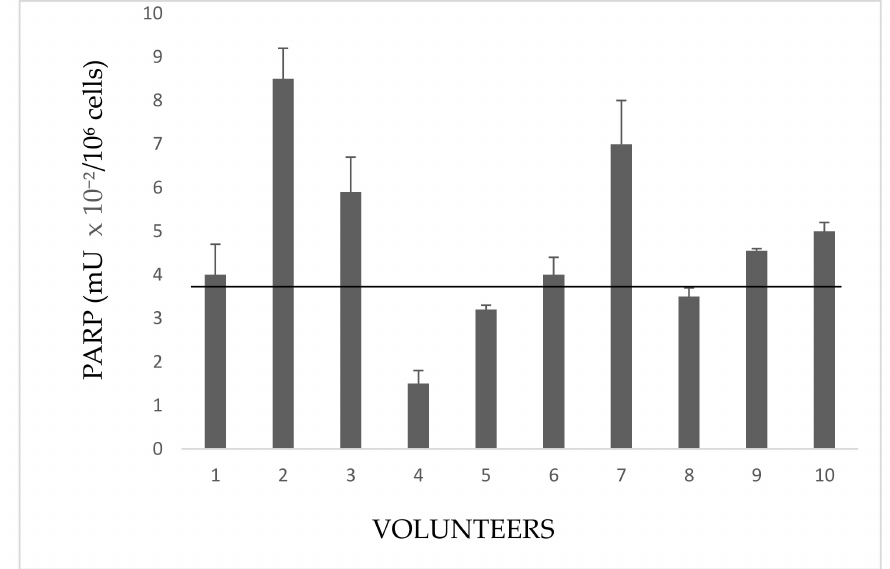
Figure 2. PARP activity in lymphocytes from Exposed People. ( A ) Volunteers with both familiar and personal pathologies; ( B ) subjects declaring only familiar diseases; ( C ) healthy people with neither familiar nor personal pathologies. The values are mean averages of duplicate measures from two different lysate preparations (20 µ g proteins per each assay). The black line is the cut-off, the upper limit of PARP activity in controls (Figure 1).